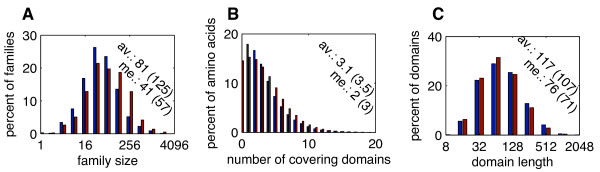
Statistics of EVEREST domains. Blue: EVEREST release 1; Red: EVEREST release 2; av: average value for release 1 (release 2); me:median value for release 1 (release 2). A: Distribution of the sizes of domain families (release 1: 1.4 × 104 families, release 2: 2 × 104 families, logarithmic bins). B: Distribution of the number of domains covering every amino acid. (release 1: 4.2 × 107 amino acids, release 2: 7.7 × 107 amino acids, no binning). C: Distribution of domain length (release 1: 106 domains, release 2: 2.5 × 106 domains, logarithmic bins).